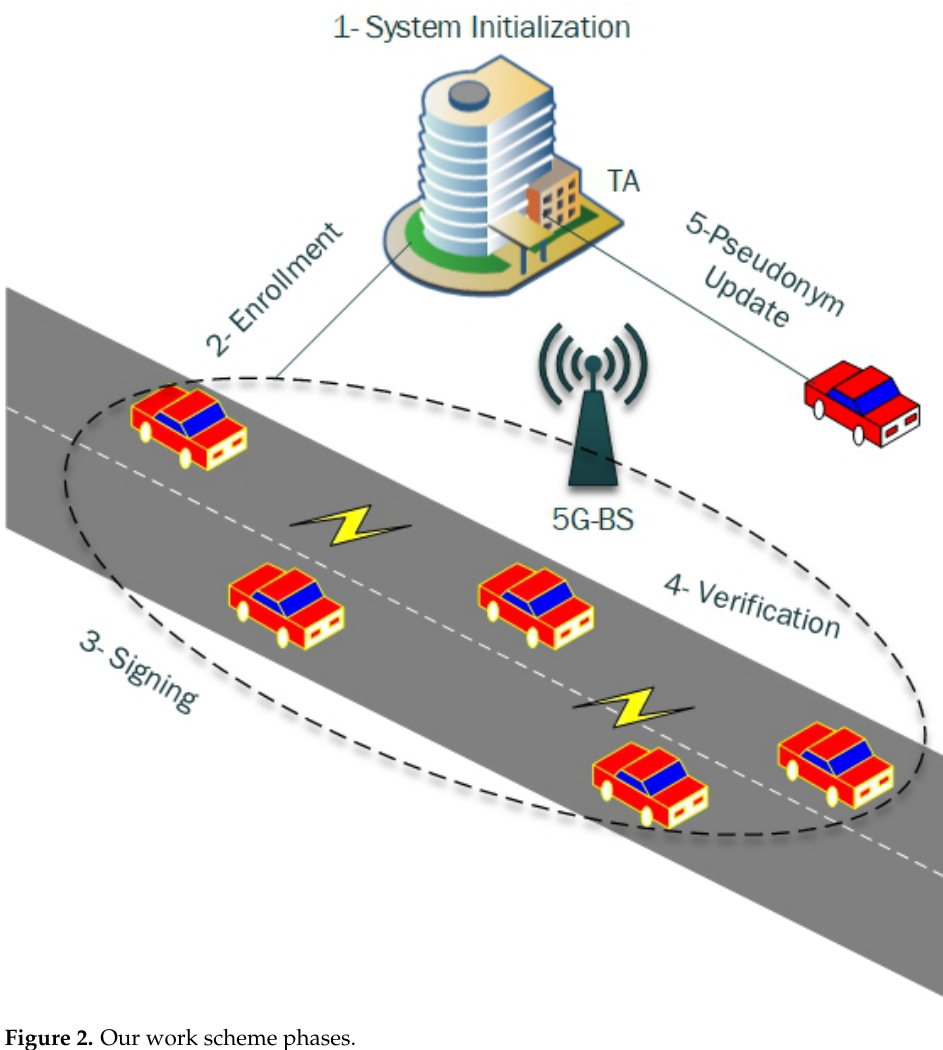
Figure 2. Our work scheme